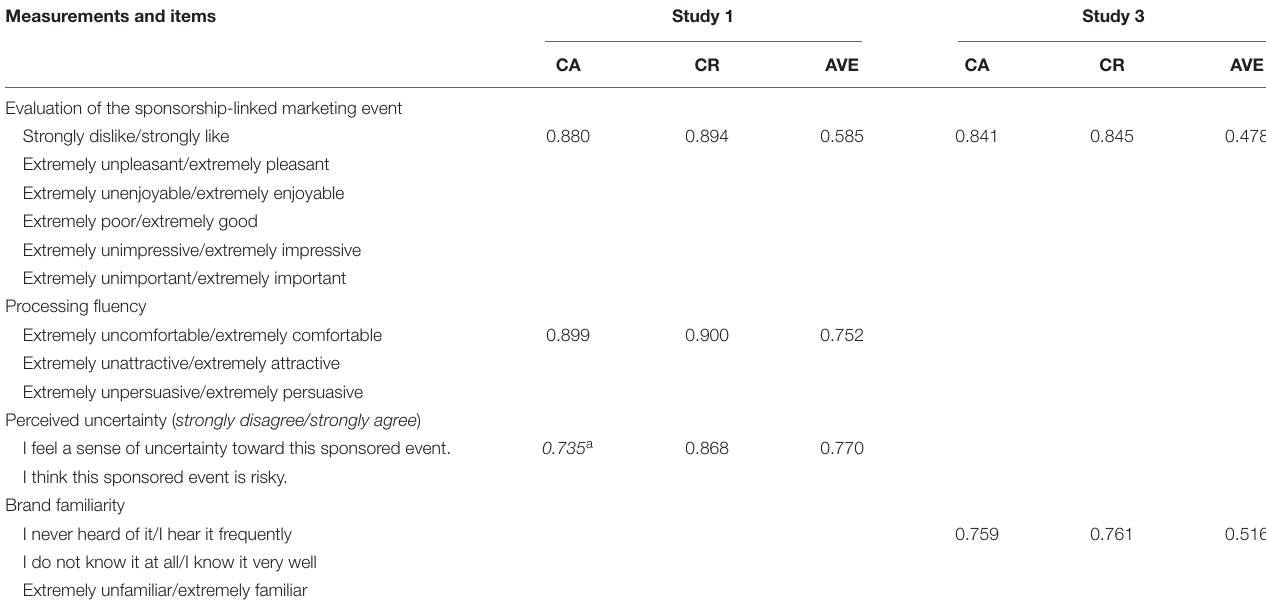
TABLE 1 | Measurements: items, reliabilities and validities (Study 1 and Study 3). Measurements and